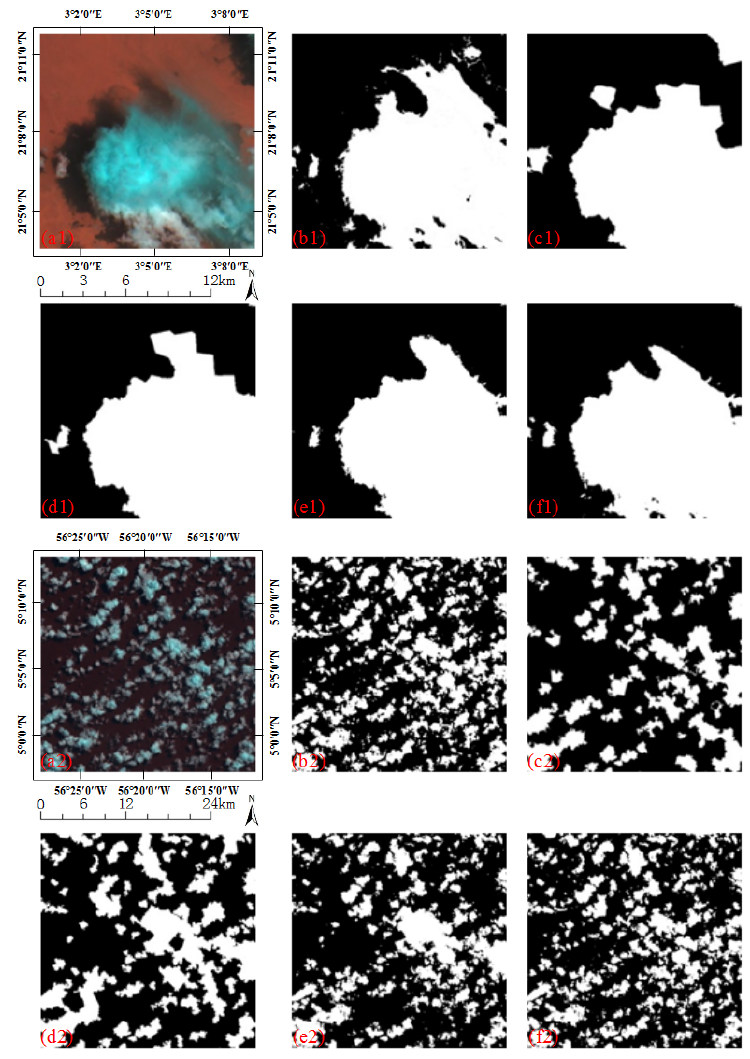
Figure 5. Visual comparisons of cloud detection results of different frameworks. ( a1 , a2 ) Color composite images ( a1 and a2 are subsets of Landsat 8 images LC81930452013126LGN01 and LC82290572014141LGN00, respectively). ( b1 , b2 ) Ground truth. ( c1 , c2 ) Results of the simple